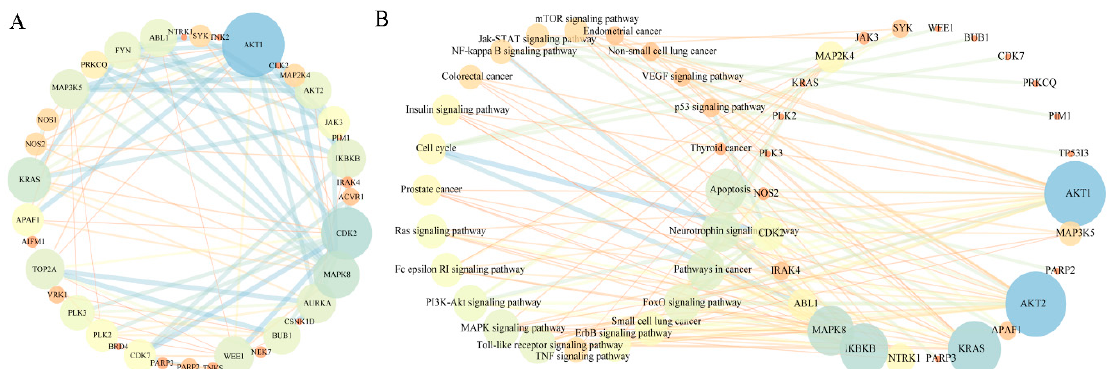
Figure 5. Analysis of pharmacological network. ( A ) PPI (protein–protein interaction) network created by uploading the top 40 target proteins to STRING database. The larger circle that represents the target proteins is considered to contain the vital ones. ( B ) TP (Target–pathway) network based on the KEGG pathway. The size of circle represents the importance degree for the target protein and pathway.